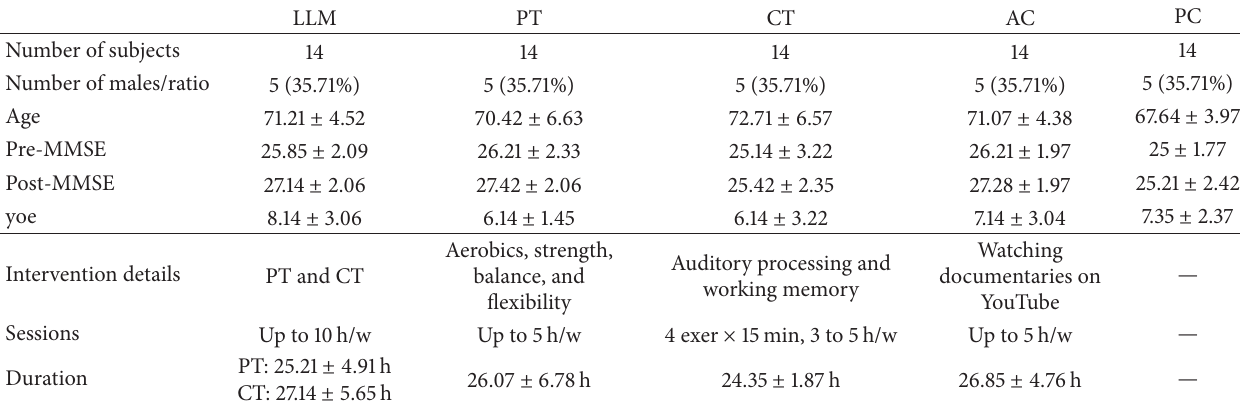
Table 1: Subject pool (means ± SDs) and training type